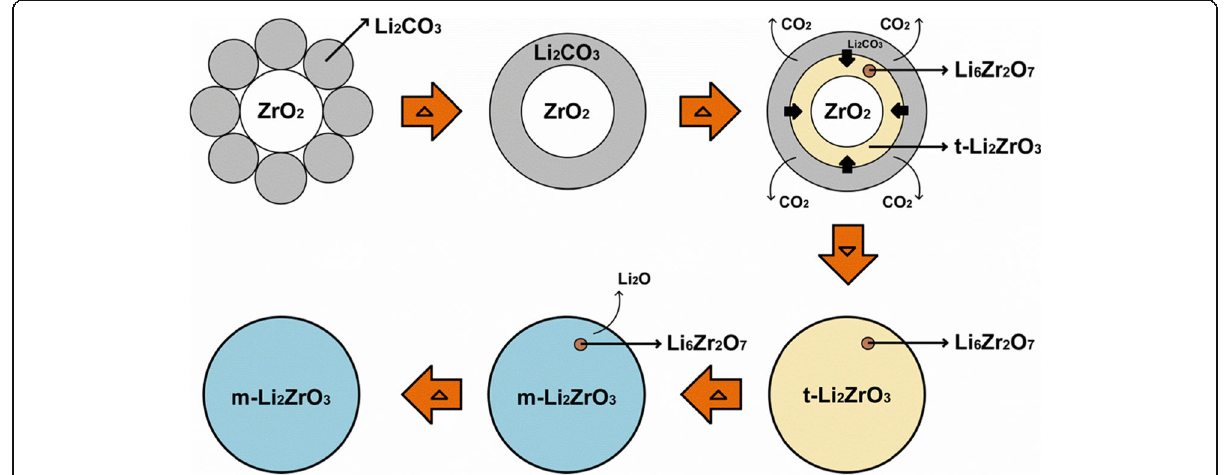
Fig. 11 Schematic representation of the reaction model for the formation of m-Li 2 ZrO 3 during the solid-state